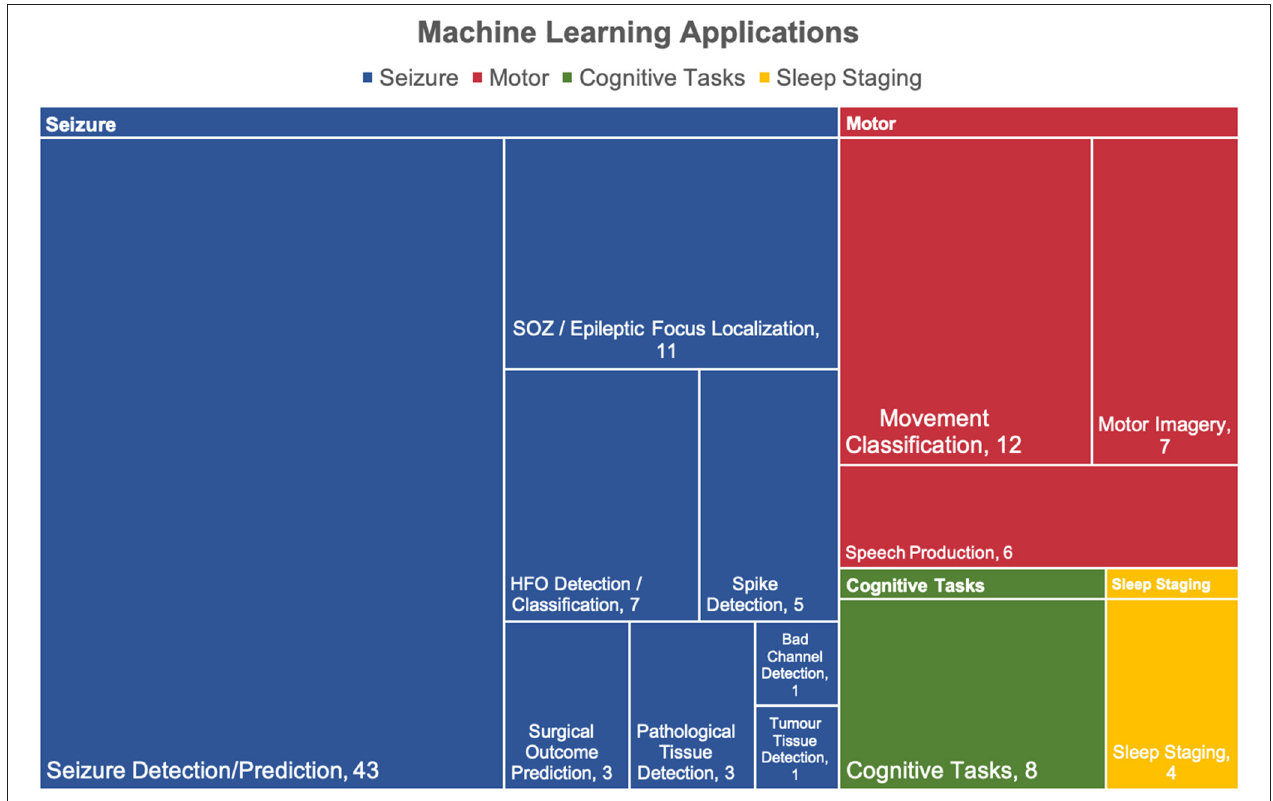
FIGURE 5 | Applications of machine learning in intracranial EEG. The applications were divided into 4 categories: seizure, motor, cognitive tasks. Over half of the articles were relevant to seizures. Four studies had more than one application thereby leading to a total of 111 applicants for 107 articles.